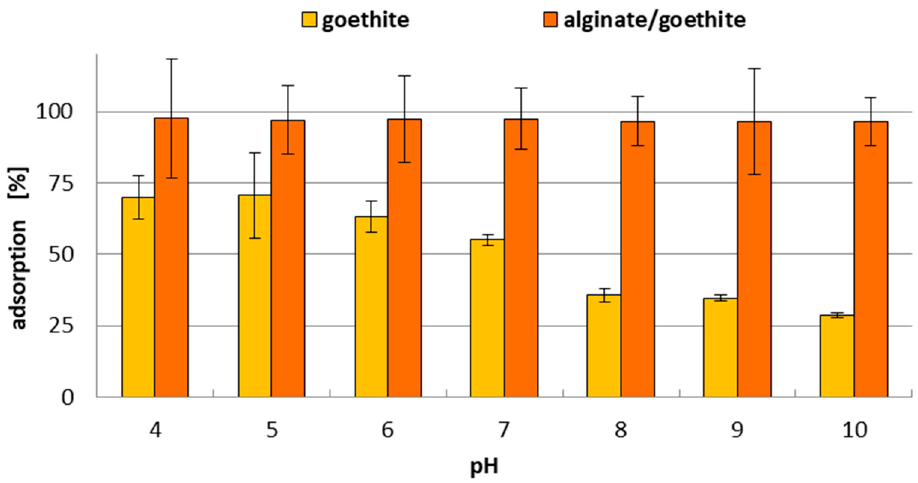
Figure 5. Effect of pH on phosphate adsorption onto goethite and alginate/goethite beads.